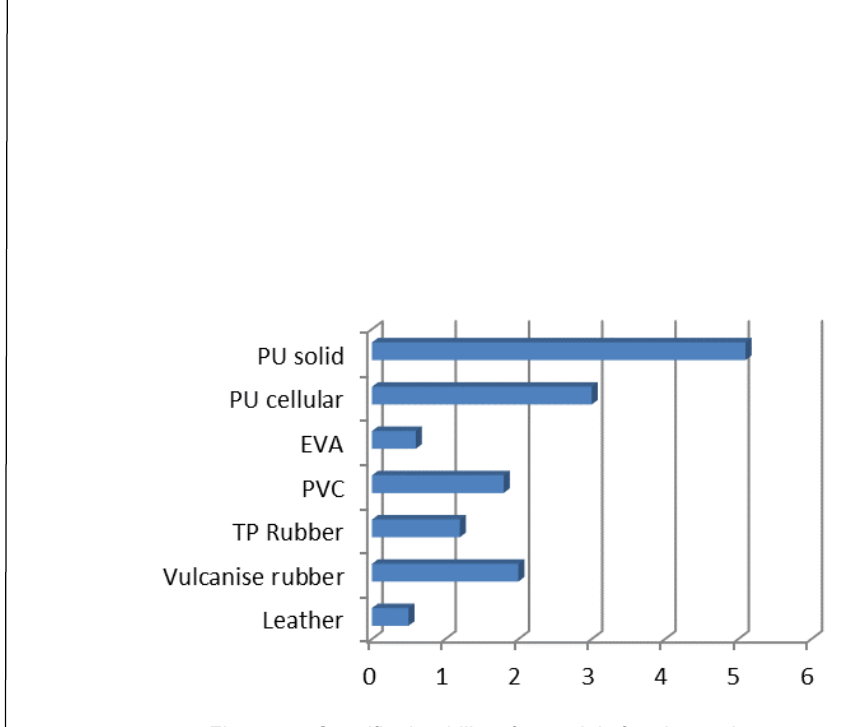
Figure 5 – Specific durability of materials for shoe soles Рис . 5 – Удельная прочность материалов для подошв обуви Слика 5 – Специфична трајност материјала за ђонове